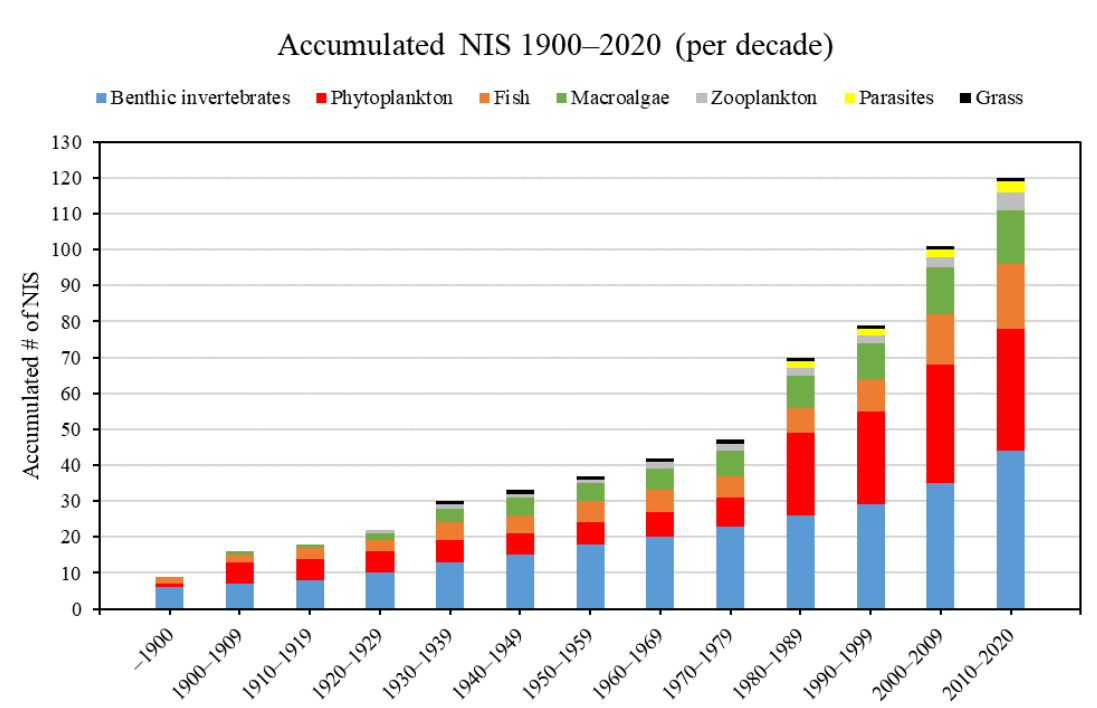
Figure 3. Accumulated number of NIS per decade. The nine NIS introductions recorded before the year 1900 are merged in the first bar: Mya arenaria (1245 – 1295), Teredo navalis (1853), Platorchestia platensis (1860), Cyprinus carpio (1879), Amphibalanus improvisus (1880), Crassostrea virginica (1880), Cordylophora caspia (1895), Oncorhynchus mykiss (1899), and Prorocentrum triestinum (1899). The three species first recorded in 2021 are not included.